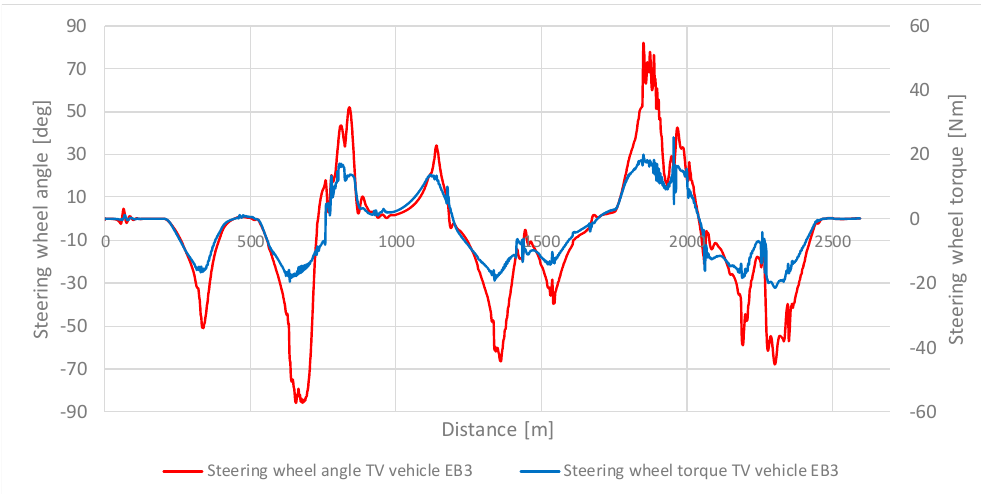
Figure 26. The TV vehicle with EB3 suspension: steering wheel angle (red) and steering wheel torque (blue).